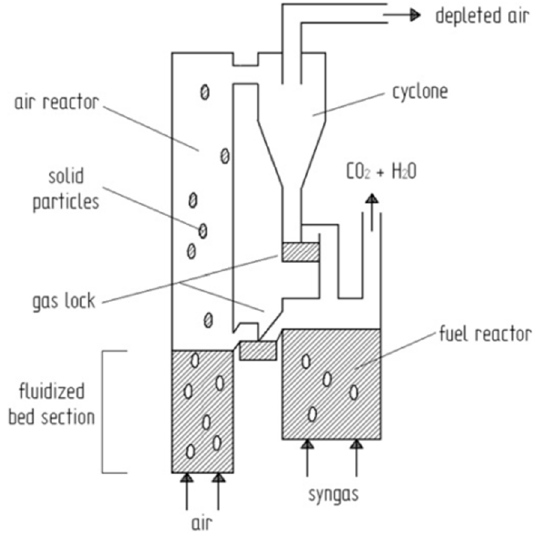
Figure 18. Layout of a power plant using chemical looping combustion with NiO and syngas [121].